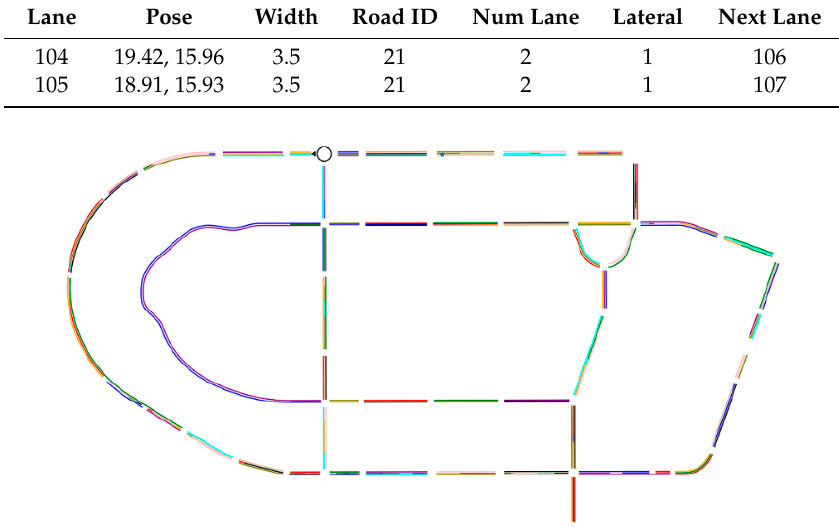
Table 6. Example of data from the high definition-map (HD-Map) database.